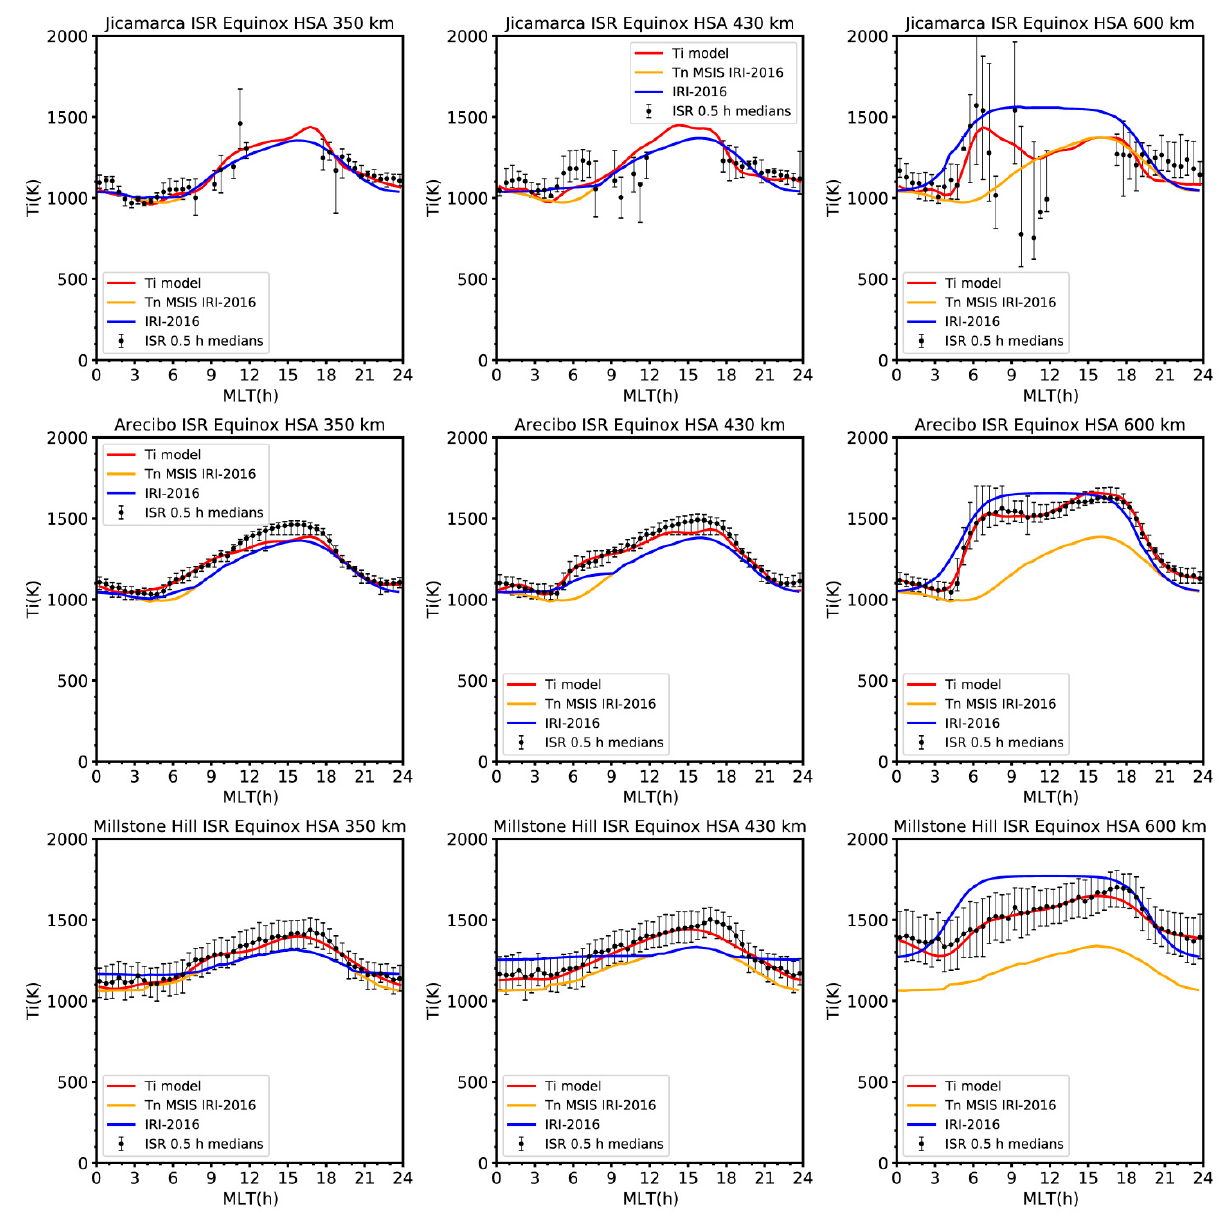
Figure 8. The same as Figure 7, but for high solar activity (PF10.7 =